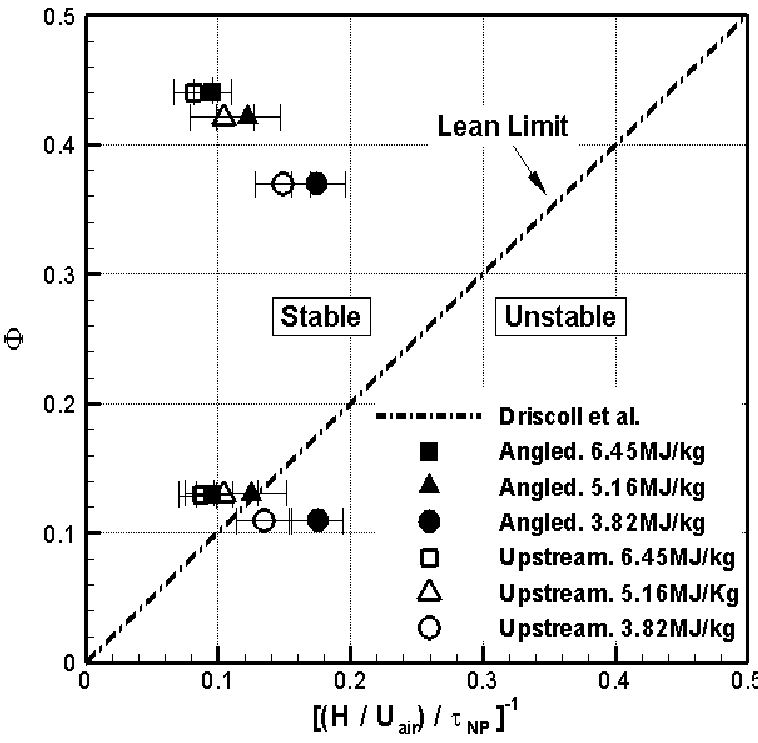
Figure 4. Comparison among the lean stable flame limits according to the location of fuel injection, Φ , and the correlation plot of Driscoll and Rasmussen